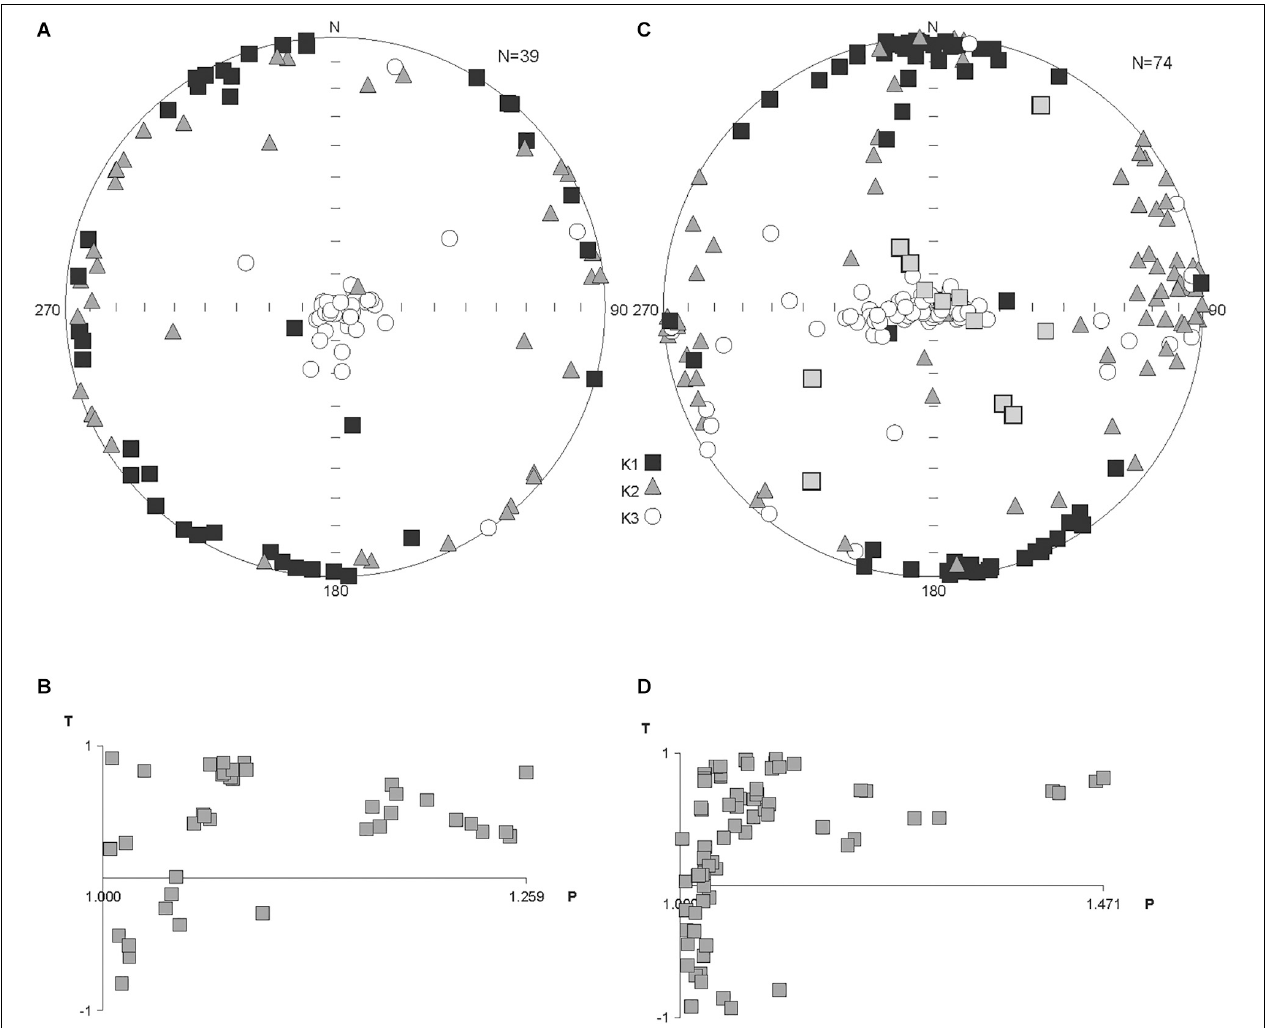
FIGURE 3 | (A) Equal area projection of AMS data from DB (geographic coordinates). Note that K min is vertical. The core is not oriented. (B) Jelinek (1981) plot of the shape factor ( T ) versus the degree of anisotropy ( P j ) for the DB data. Note that most specimens have an oblate fabric. (C) Equal area projection of AMS data from EC (geographic coordinates). Note that most of the K min axes are vertical but the specimens display a smeared distribution. Gray squares ( K max ) are specimens from diagenetically altered breccia have a vertical or near vertical K max . K max also has an NNE-SSE trend, and K int has an E-W trend. (D) Jelinek plot of the shape factor ( T ) versus the degree of anisotropy ( P ) for the EC